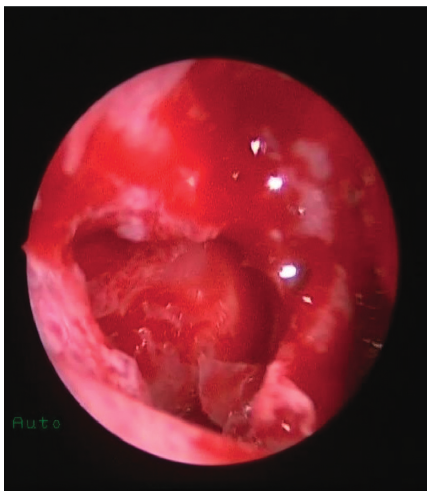
Figure 4: Postoperative endoscopic view showing wide middle meatus antrostomy with patent maxillary sinus.